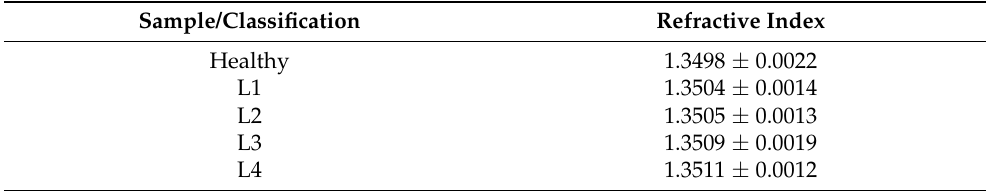
Table 1. Average refractive indices of plasma samples measured with the Abbe refractometer accord- ing to the visual classification of the degree of lipemia assigned by the blood bank technician. We can see that despite the visible differences in turbidity, the refractive index’s change starts from the third digit considering the